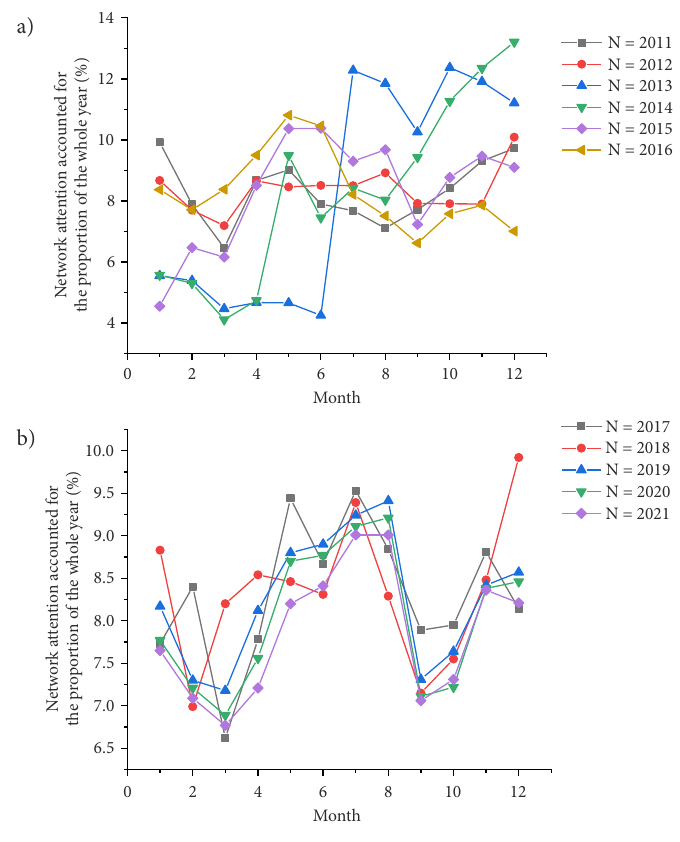
Figure 7. Monthly change of OPA (n – “year”) (a. 2011–2016; b.